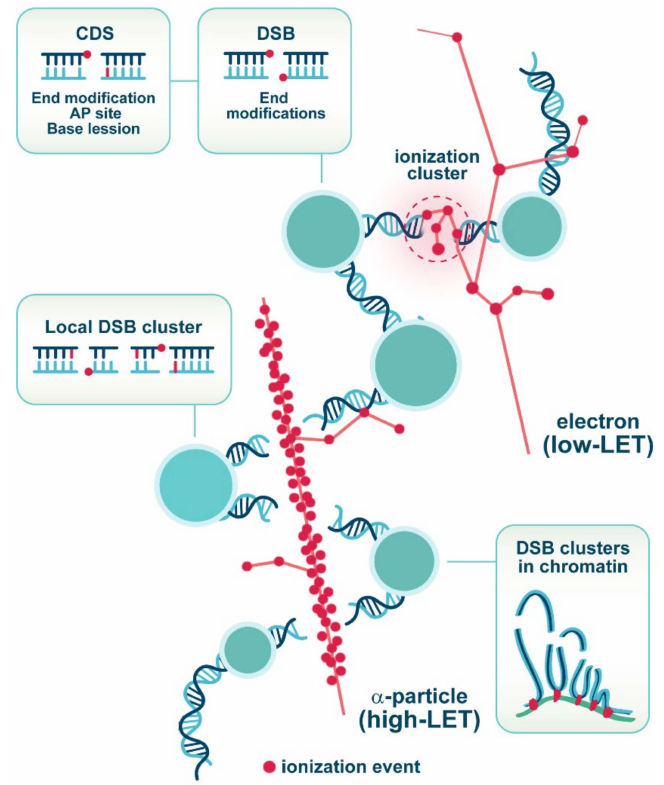
Figure 1. Generation of DSBs by low-LET electrons and high-LET α -particles. Ionization events along the radiation tracks are presented as red dots, while the DNA molecule is rendered as part of chromatin organized with nucleosomes. The formation of DSBs of different complexity is induced by both low- and high-LET IR and these DSBs frequently harbor chemically modified DNA ends that are not directly ligatable and require additional processing. Clustered damage sites (CDS) of different damage permutations are detectable after low-LET IR and their number increases with increasing LET. Notably, high-LET IR generates with significantly higher probability DSB clusters, comprising multiple DSBs located in close proximity along the DNA that destabilize chromatin and, thus, the processing of the individual DSBs that always takes place in the context of chromatin.